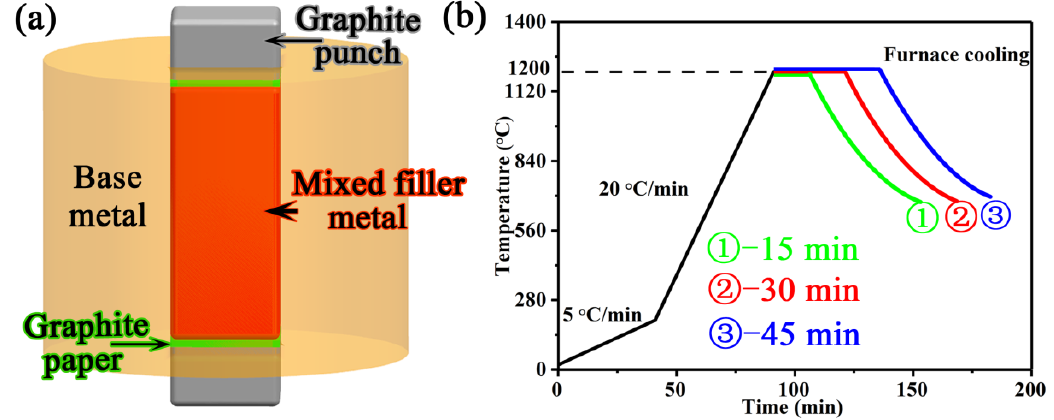
Figure 2. Schematic of the brazing assembly ( a ), time–temperature profile of the wide-gap brazing process ( b ).